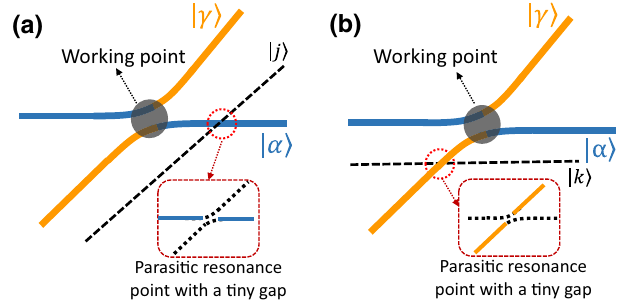
FIG. 13. Leakage channel in a multianticrossing system com- prising a main avoided crossing (resulting from the resonance interaction between | α (cid:2) and | γ (cid:2) ) with a dominated energy gap (working point) and an avoided crossing involving (a) | j (cid:2) or (b) | k (cid:2) with a tiny energy gap. In (a) during gate operations, the system will sweep through the parasitic resonance point, poten- tially causing leakage to state | j (cid:2) and in (b) the system will approach the parasitic resonance point, resulting in a population swap between | k (cid:2) and | γ (cid:2)